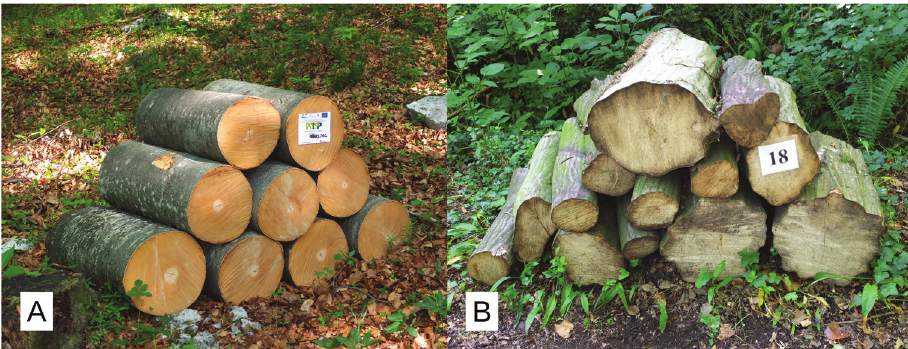
Figure 10. Two wood piles built from freshly cut wood. A F. sylvatica , freshly built B C. betulus , two months after being